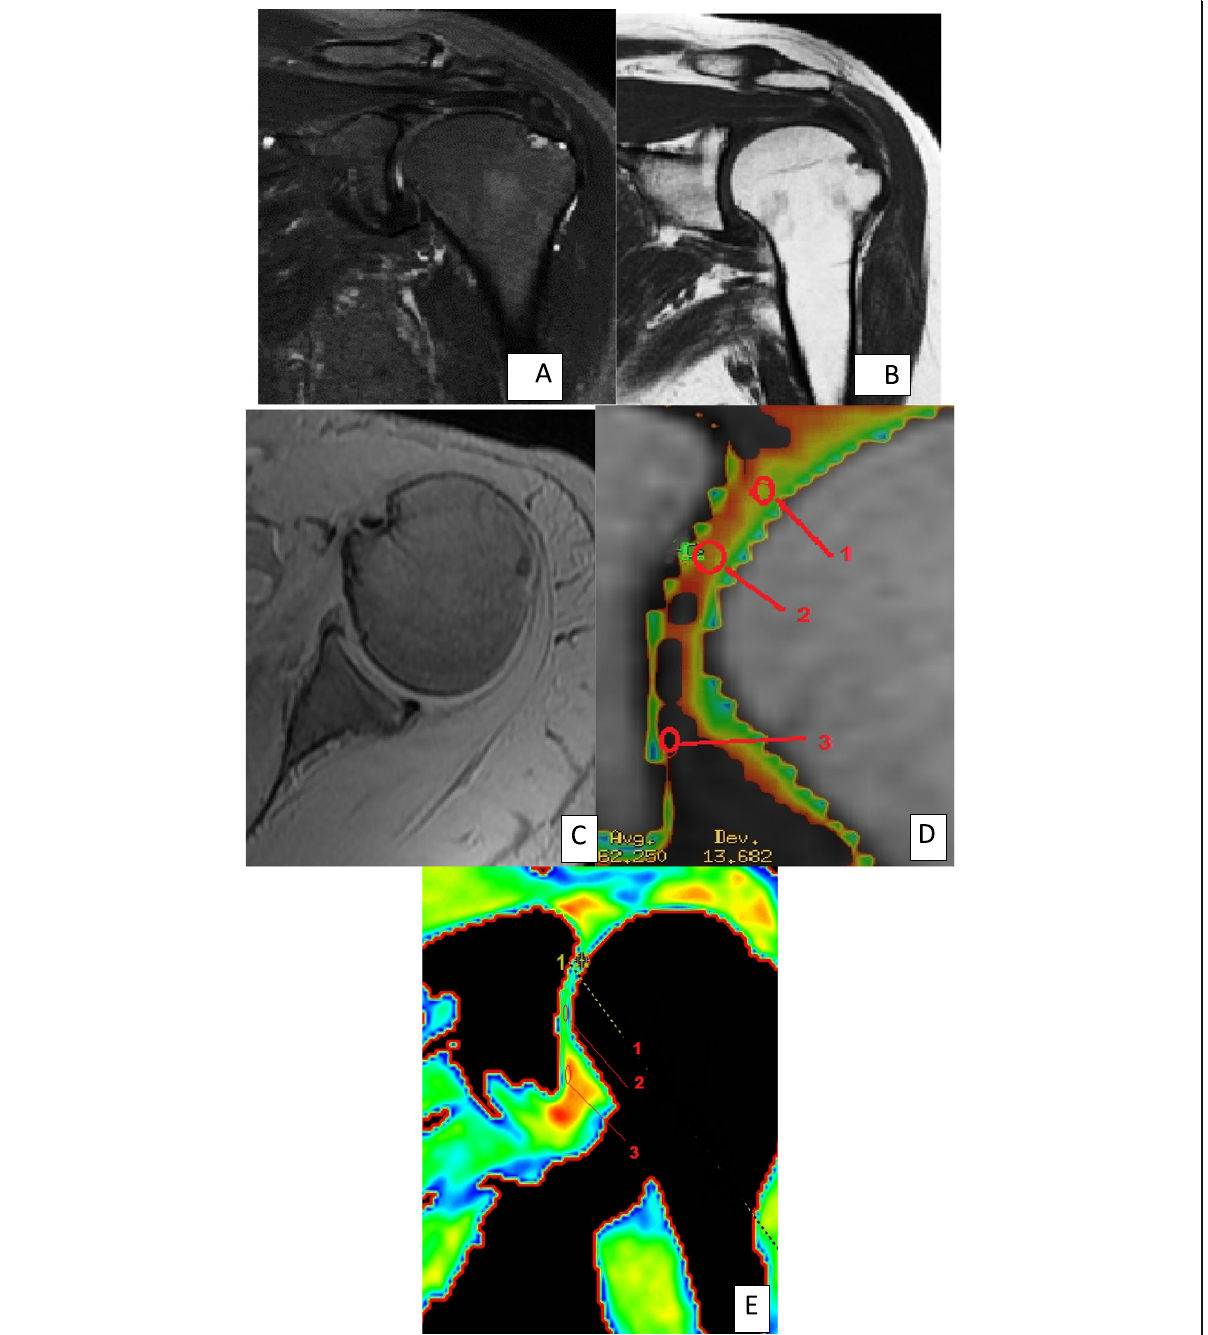
Fig. 2 a Coronal T1 WI. b Coronal proton density (PD) WI. c An axial T2 gradient echo WI revealed osteoarthritic changes in form of osteophytes, irregular articular surface and abnormal sub articular bone marrow SI (grade II). d T2 colored mapping. e A processed image showed T2 values of 62.4 ms, 63.83 ms and 59.56 ms, glenoid zone (3), midzone (2), and humeral zone (1) respectively ( red